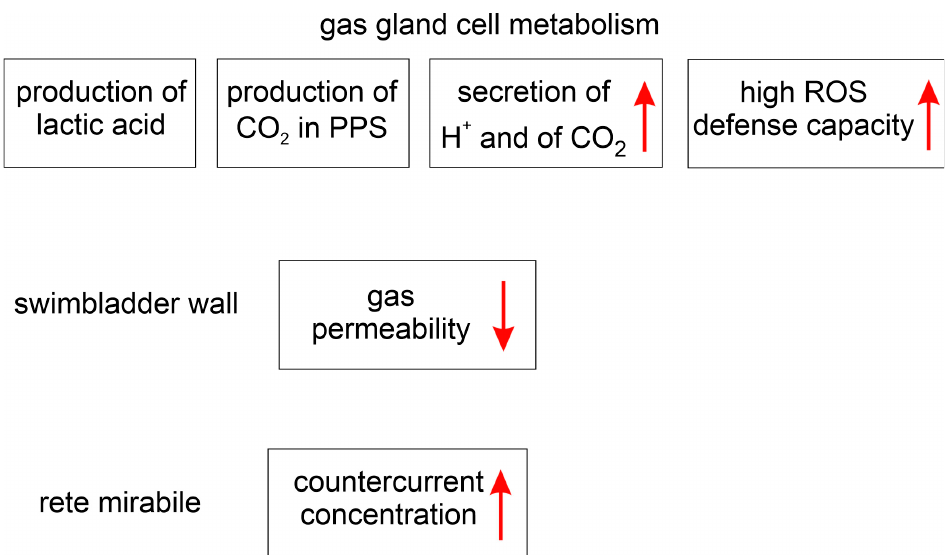
Figure 3. Functional characteristics of eel swimbladder and improvements related to silvering, indicated by a red arrow. Silvering results in an improvement of the secretory activity of gas gland cells, and in an improvement of the ROS defense capacity. Gas permeability of the swimbladder wall is reduced; the countercurrent concentrating capacity of the rete mirabile is enhanced. PPS, pentose phosphate shunt, ROS, reactive oxygen species.